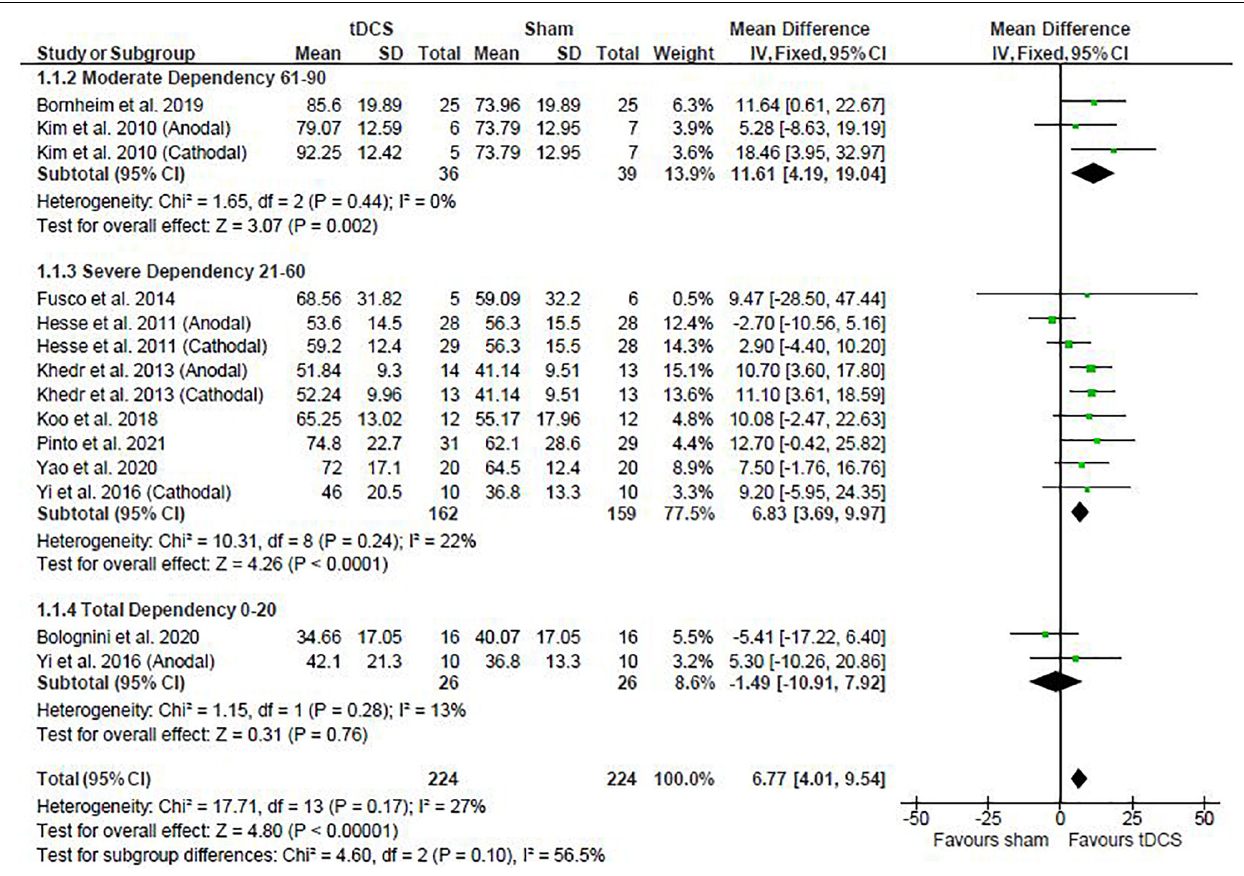
Frontiers in Aging Neuroscience |